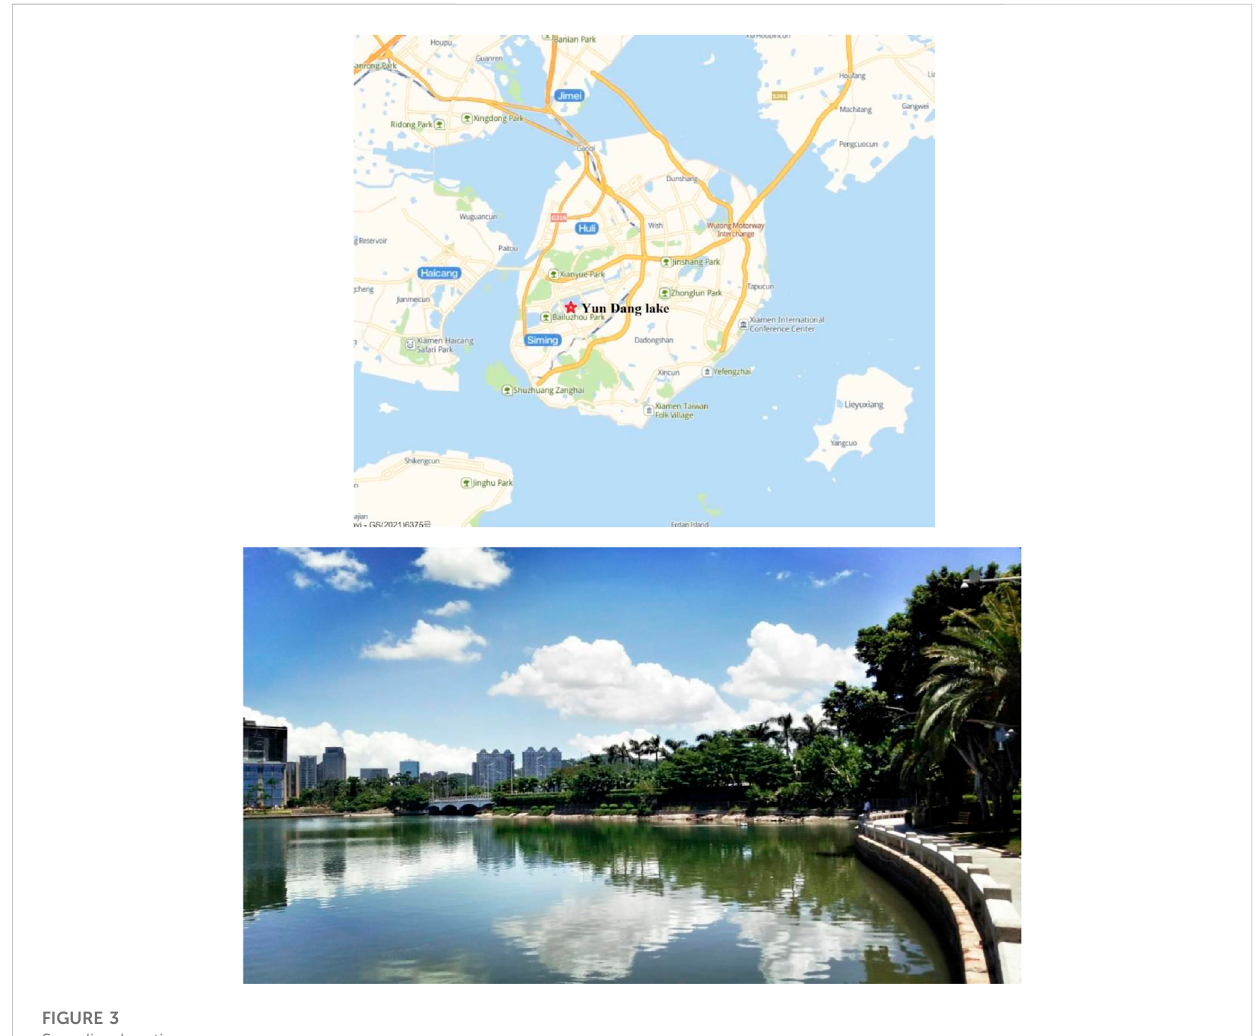
FIGURE 3 Sampling location.